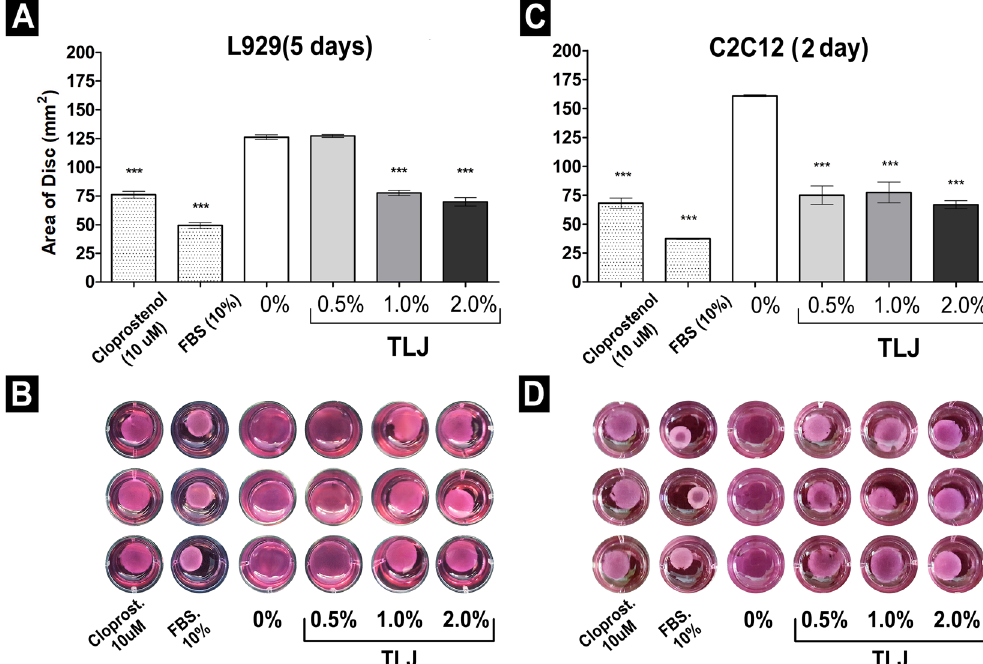
Figure 4. Demonstration of the contraction of collagen gel discs populated by L929 or C2C12 induced by different concentrations of TLJ. ( A ) Bar graphic comparing the mean area from collagen discs populated by the L929 cell line treated with different concentrations of buffered TLJ (0, 0.5, 1 or 2%) at 5 days in relation to the positive Controls (10 µ M of cloprostenol or 10% of FBS) and negative Control (media without FBS and TLJ: 0%). ( B ) Image of the discs showing the intensity of contraction of the diverse groups after 5 days of treatment. ( C ) Bar graphic comparing the mean area from collagen discs populated by the C2C12 cell line treated with different concentration of buffered TLJ (0, 0.5, 1 or 2%) at 2 days in relation to the positive Controls (10 µ M of cloprostenol or 10% of FBS) and negative Control (media without FBS and TLJ: 0%). ( B ) Image of the discs showing the intensity of contraction of the diverse groups after 2 days of treatment. Quantitative data were expressed as the mean area (mm 2 ) ± SEM (n = 3). *** p < 0.001 vs. the negative Control group; Statistical analysis was performed using one-way ANOVA and the Dunnett’s post-hoc